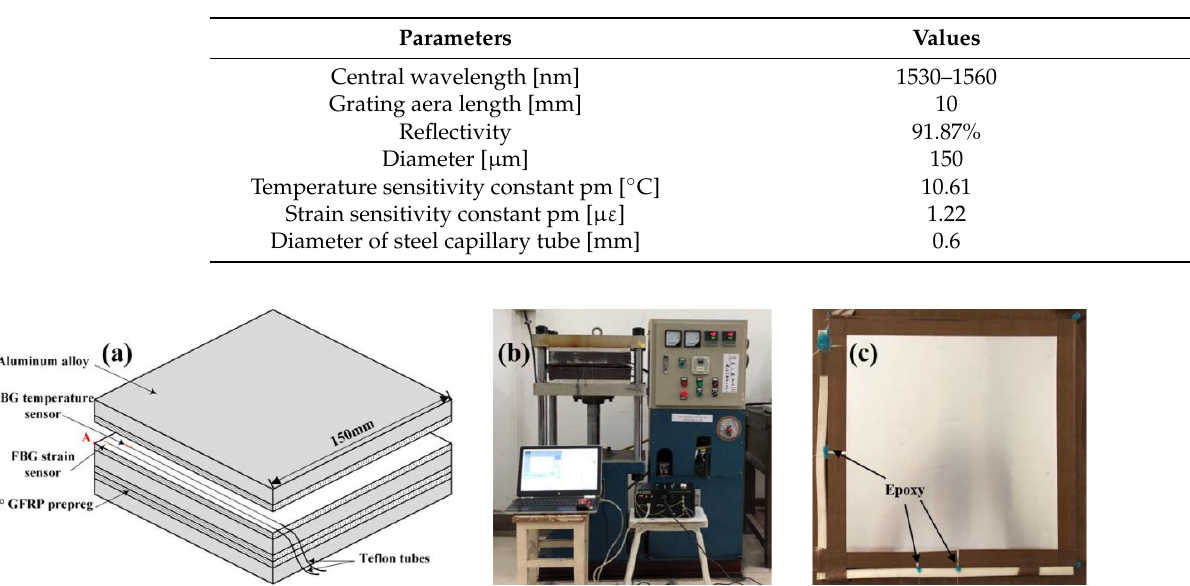
Figure 2. The temperature and pressure curves of cure process. Table 3. Basic parameters of FBG sensors.